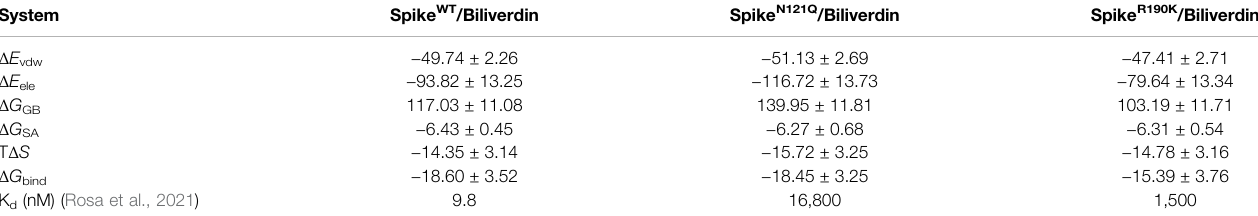
TABLE 1 | Binding free energies and individual energy terms of biliverdin in three systems calculated in MM/GBSA (kcal/mol). System